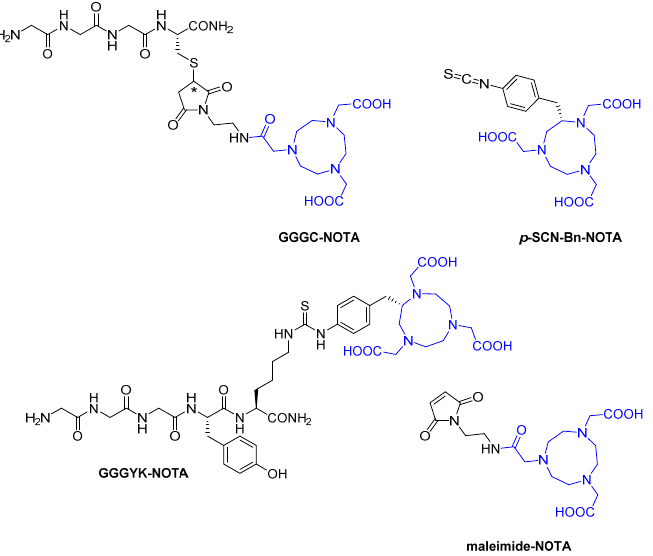
Figure 12. 1,4,7-Triazacyclononane- N , N ′ , N ″ -triacetic acid (NOTA)-based synthetic chelators applied to nanobodies for radiometal labeling. NOTA substructure is highlighted in blue.